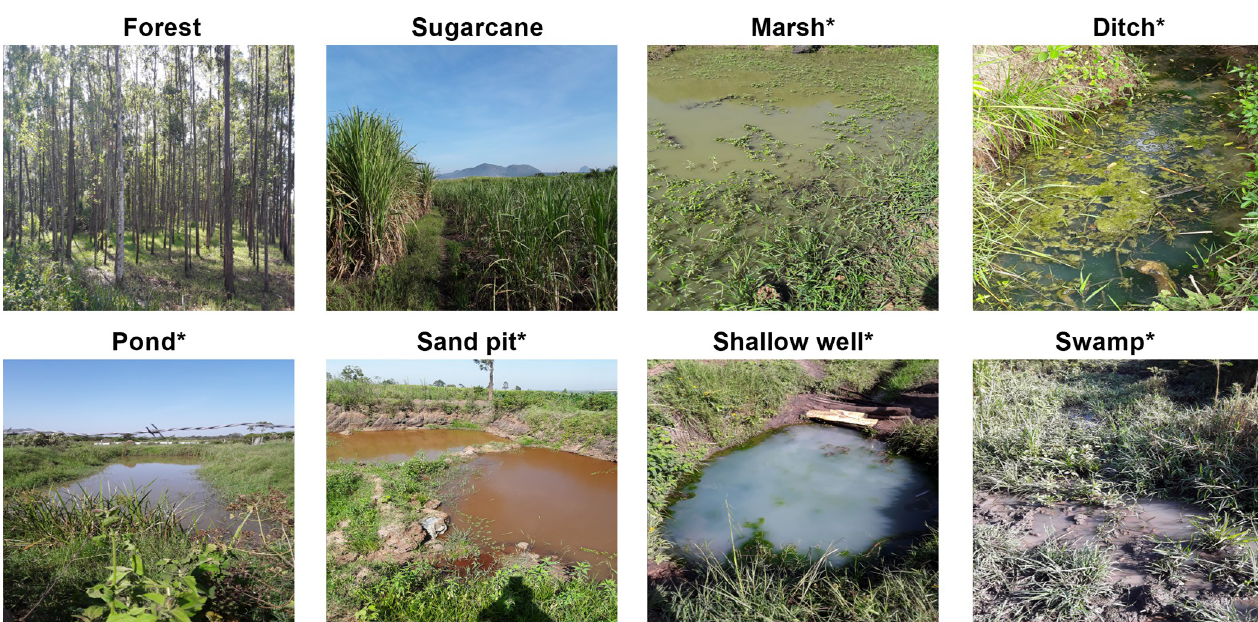
Fig 2. Habitats identified by the present study in the dry season. Habitats marked with asterisk ( * ) collectively are referred to as wetlands in this article. Elsewhere, the habitats are proxies for Anopheline larval habitats [40–46].